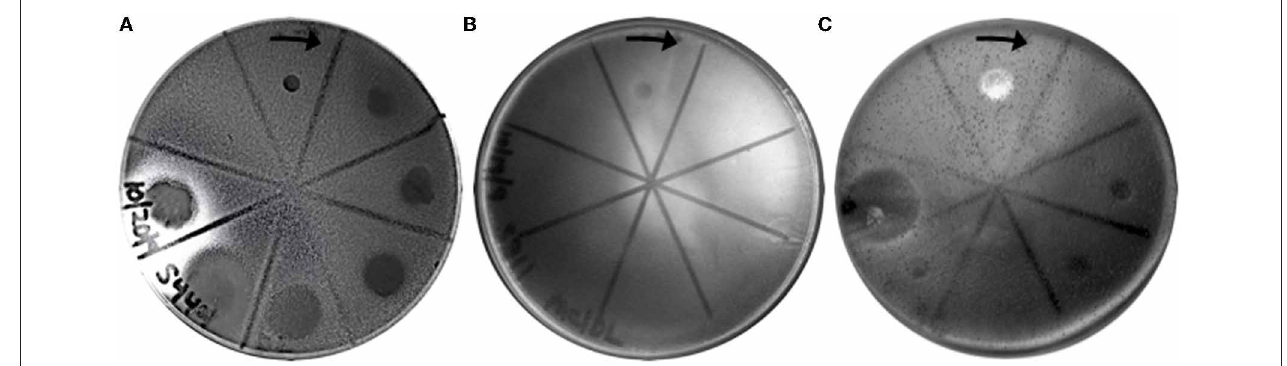
FIGURE 3 | Representative virus susceptibility of the three host classes. Virus infection was determined as in Figure 2 . (A) Completely susceptible host: All 6 SSVs tested inhibit growth of a Sulfolobus strain isolated from Lassen Volcanic National Park. (B) Completely resistant host : No SSVs inhibit growth of S. tokodaii . (C) Selectively susceptible host : 4 of 6 SSV